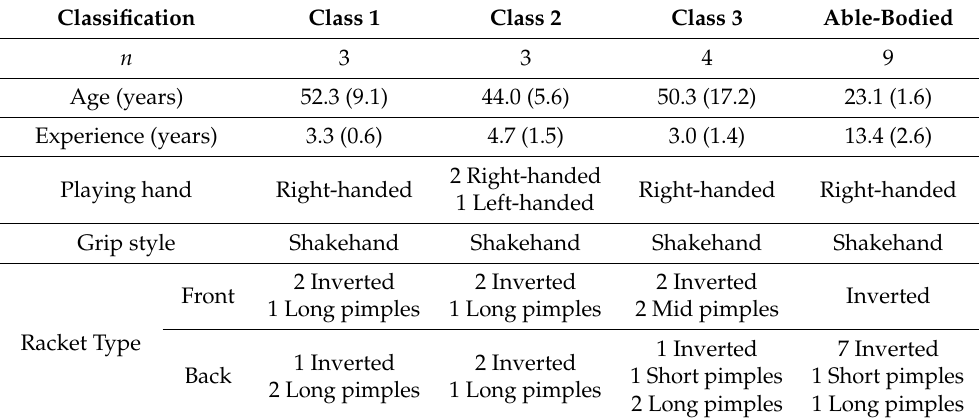
Table 1. Characteristics of 19 male wheelchair (classes 1 to 3) and able-bodied table tennis